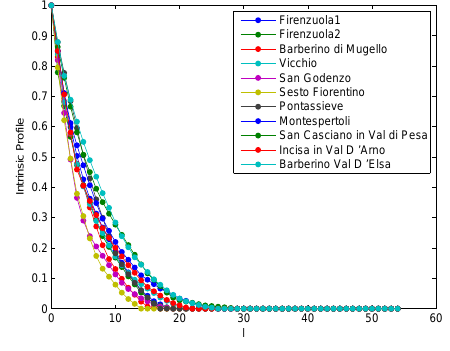
) for the 11 sites in the province of Florence. l